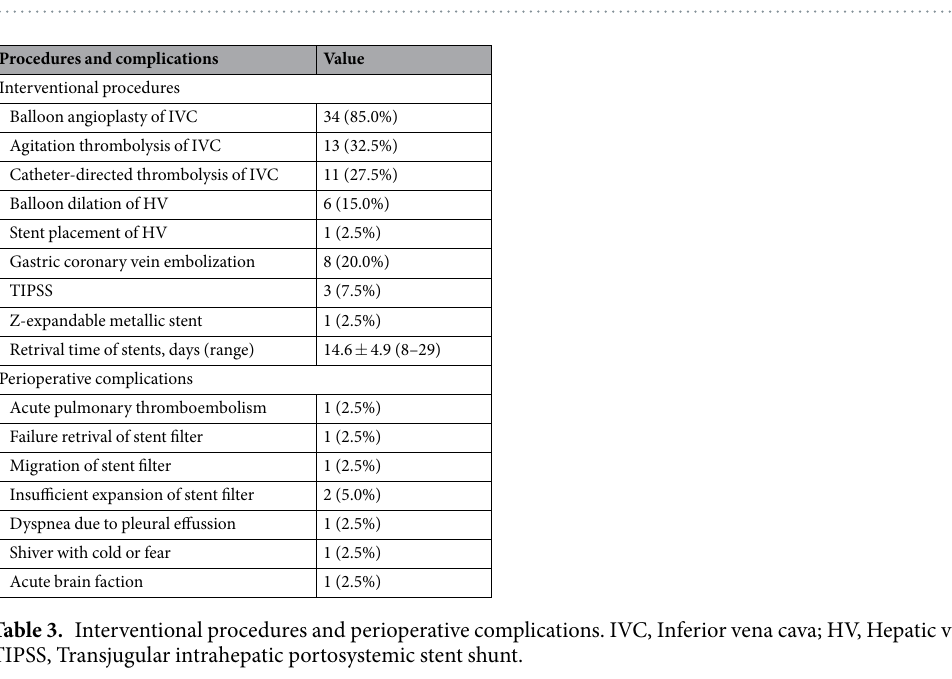
Table 2. Comorbidities and symptoms of patients with IVC thrombosis.